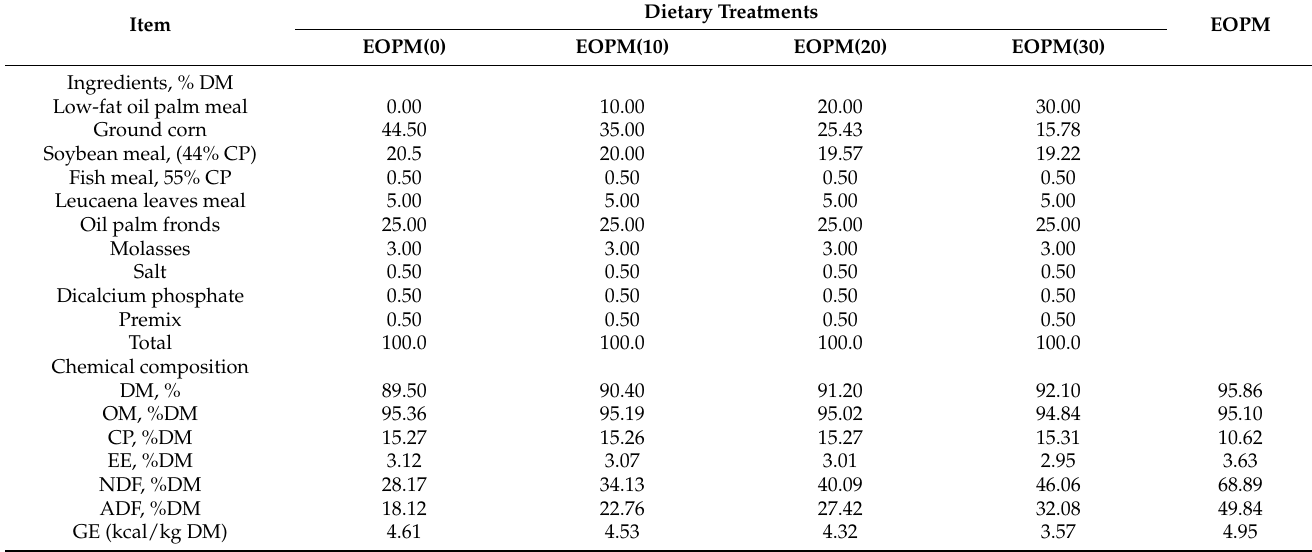
Table 1. Ingredients and chemical composition of goat diets formulated with various levels of extracted oil palm meal (EOPM) (% DM